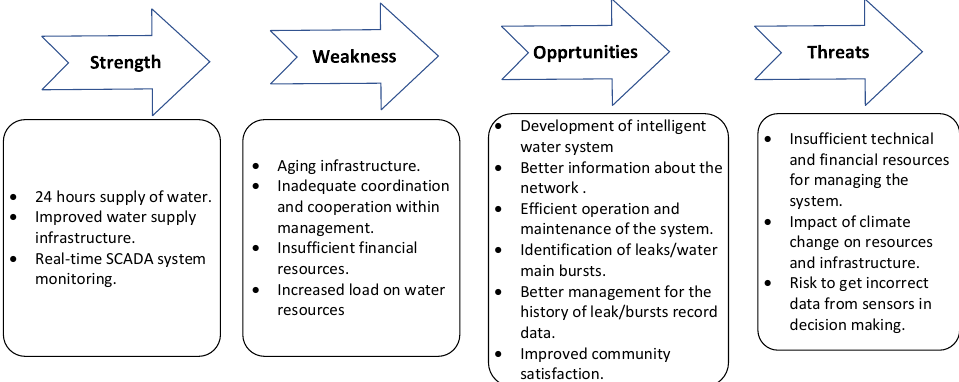
Figure 4. SWOT Analysis of Water System .